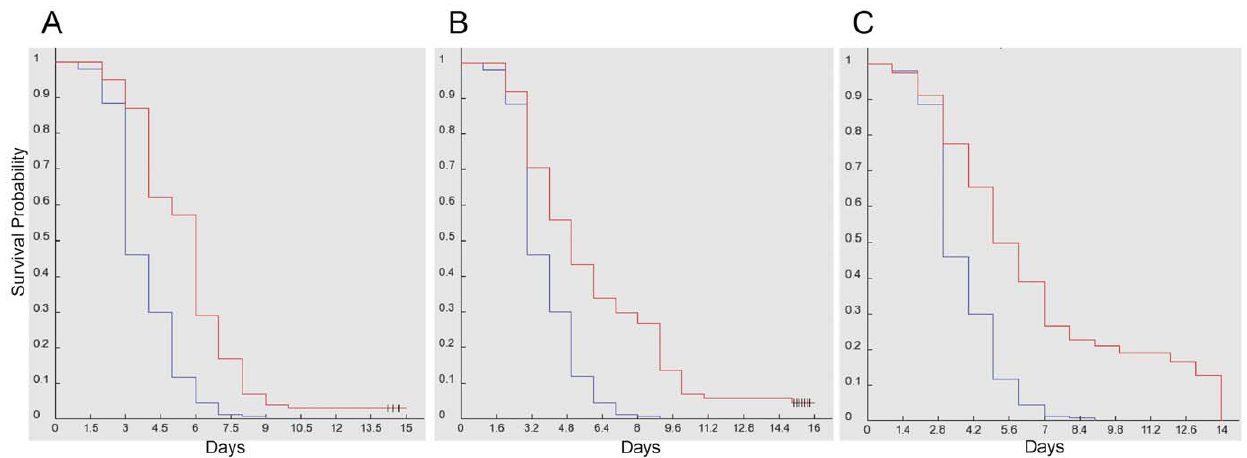
Figure 7. GGA mutant flies are hypersensitive to dietary chloroquine. Blue lines represent: GGA D males (n=181 and median survival time 2.90 days) Red lines represent a. yw males (n=97, P-value , 0.0001 and median survival time 5.25 days) b. yw; P{ GGA D } A2 males (n=151, P-value